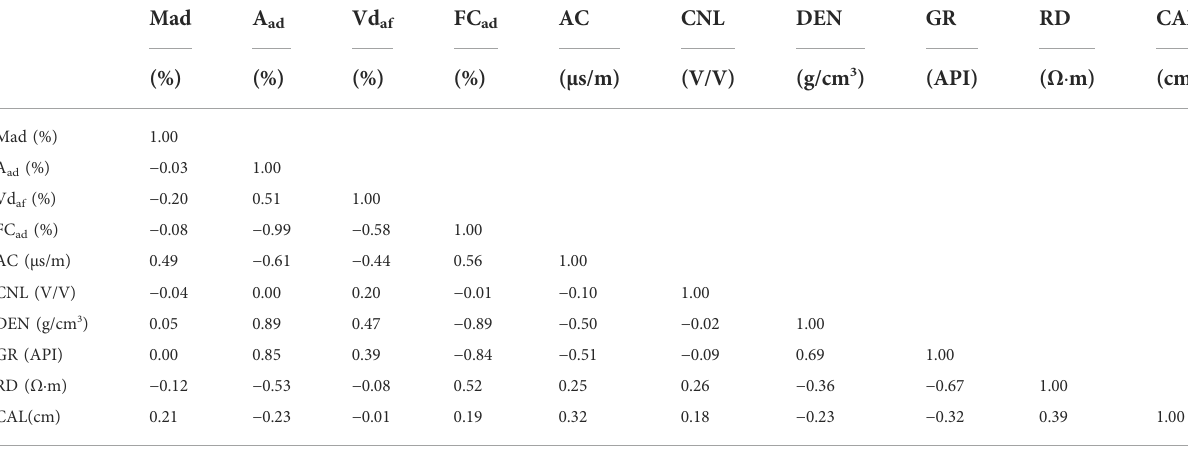
TABLE 1 The Pearson index analysis of the response values of the industrial components and the geophysical logging curves of coalbeds in the PZ